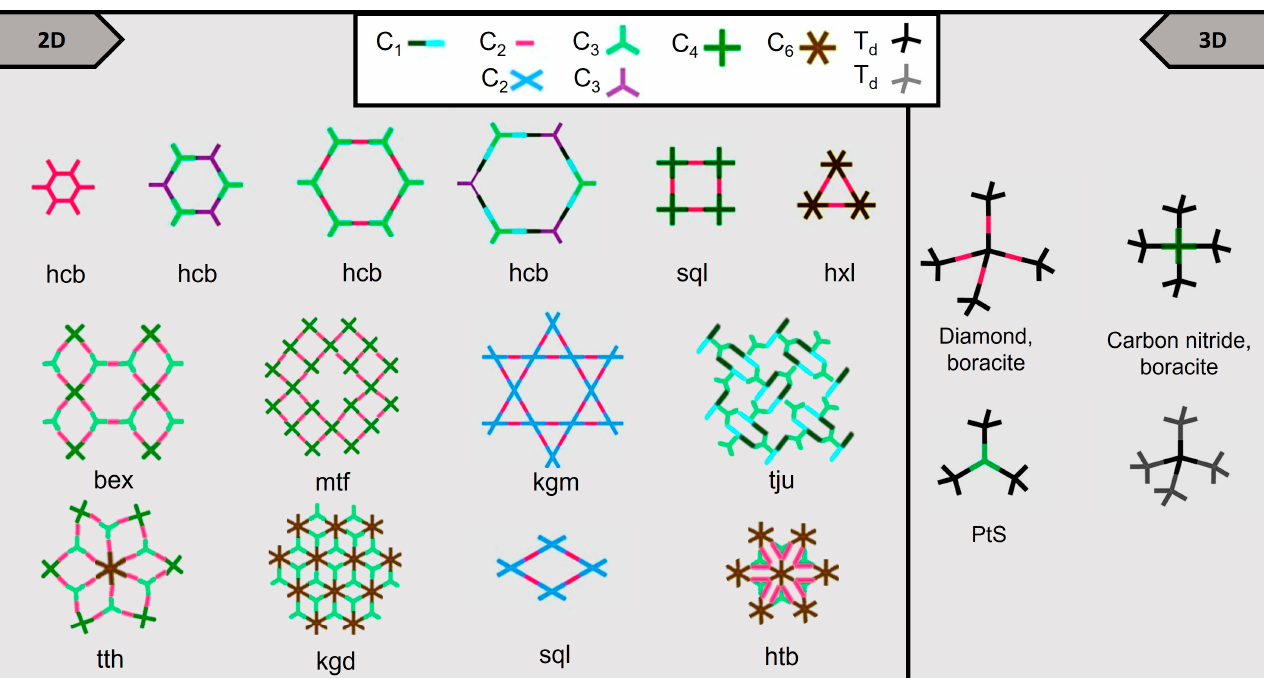
Figure 2. Topologies of COFs.